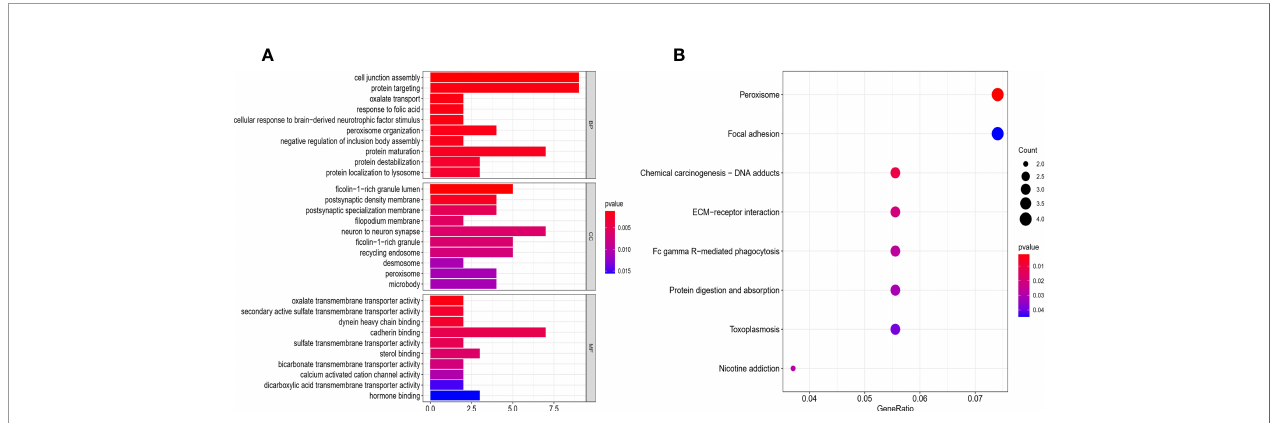
FIGURE 8 | Functional analysis based on the DEGs between the two-risk groups in the GEO cohort. (A) Barplot graph for GO enrichment (the longer bar means the more genes enriched, and the increasing depth of red mans the differences were more obvious). (B) Bubble graph for KEGG pathways (the bigger bubble means the more genes enriched, and the increasing depth of red means the differences were more obvious; q-value: the adjusted p-value).